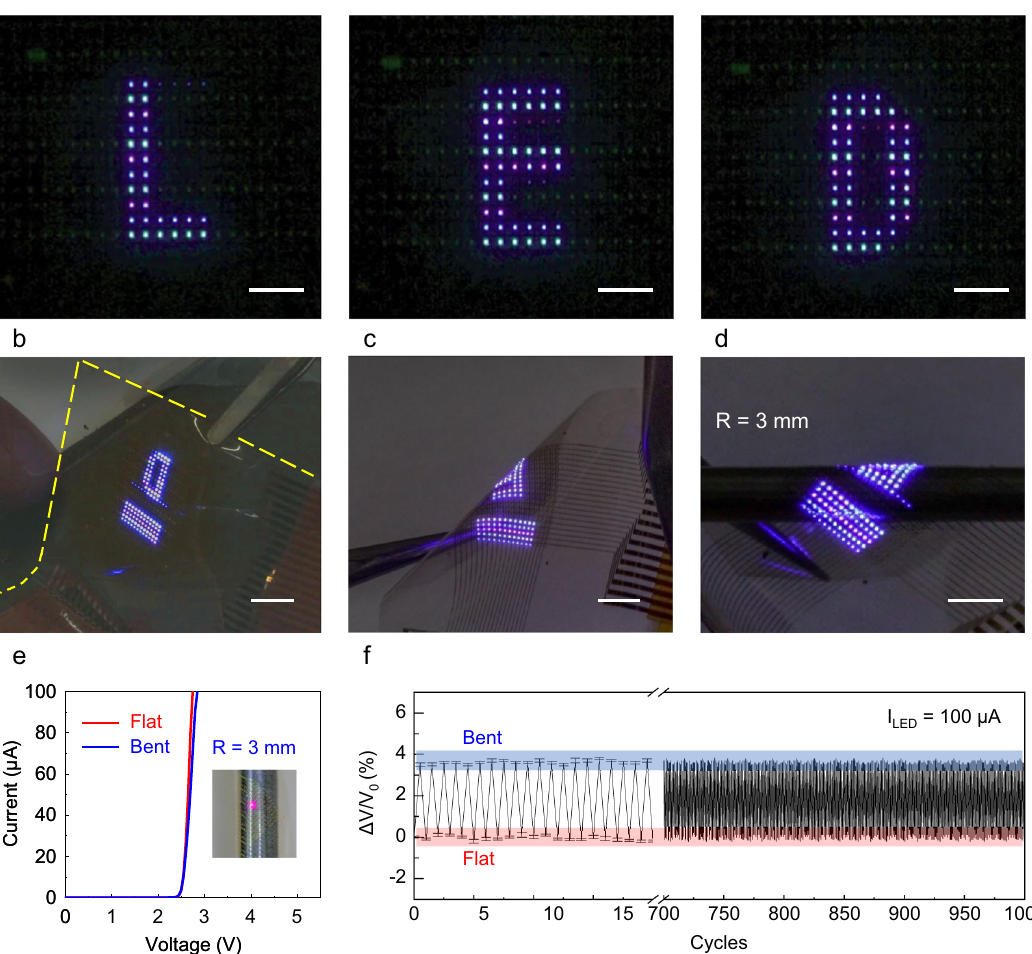
Fig. 3 Flexible full-color micro-LED display. a Optical images of the dynamic operation of micro-LED display using external driving circuit, representing the letters ‘ L, ’ ‘ E, ’ and ‘ D ’ . Scale bar: 2 mm. b Optical image of full-color micro-LED display after peeling off from the carrier substrate. Scale bar: 5 mm. c Optical image of RGB micro-LED display, when bent by tweezers. Scale bar: 5 mm. d Photograph of ultrathin RGB micro-LED display on a glass rod with 3 mm radius. Scale bar: 6 mm. e Current – voltage curves of micro-LEDs, when bent with R = 3 mm. f Relative voltage change of micro-LED during cyclic bending test with a bending radius of 3 mm. The injected current during the test is fi xed at 100 μ